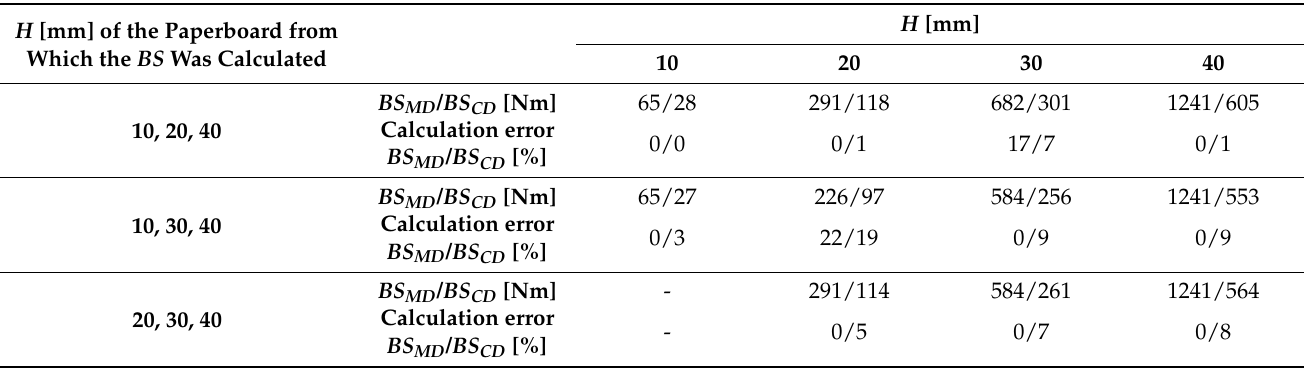
Table 5. Results of BS MD and BS CD calculations using method II and calculation errors for honeycomb paperboard TL200/FL140/TL200 and D = 15 mm.